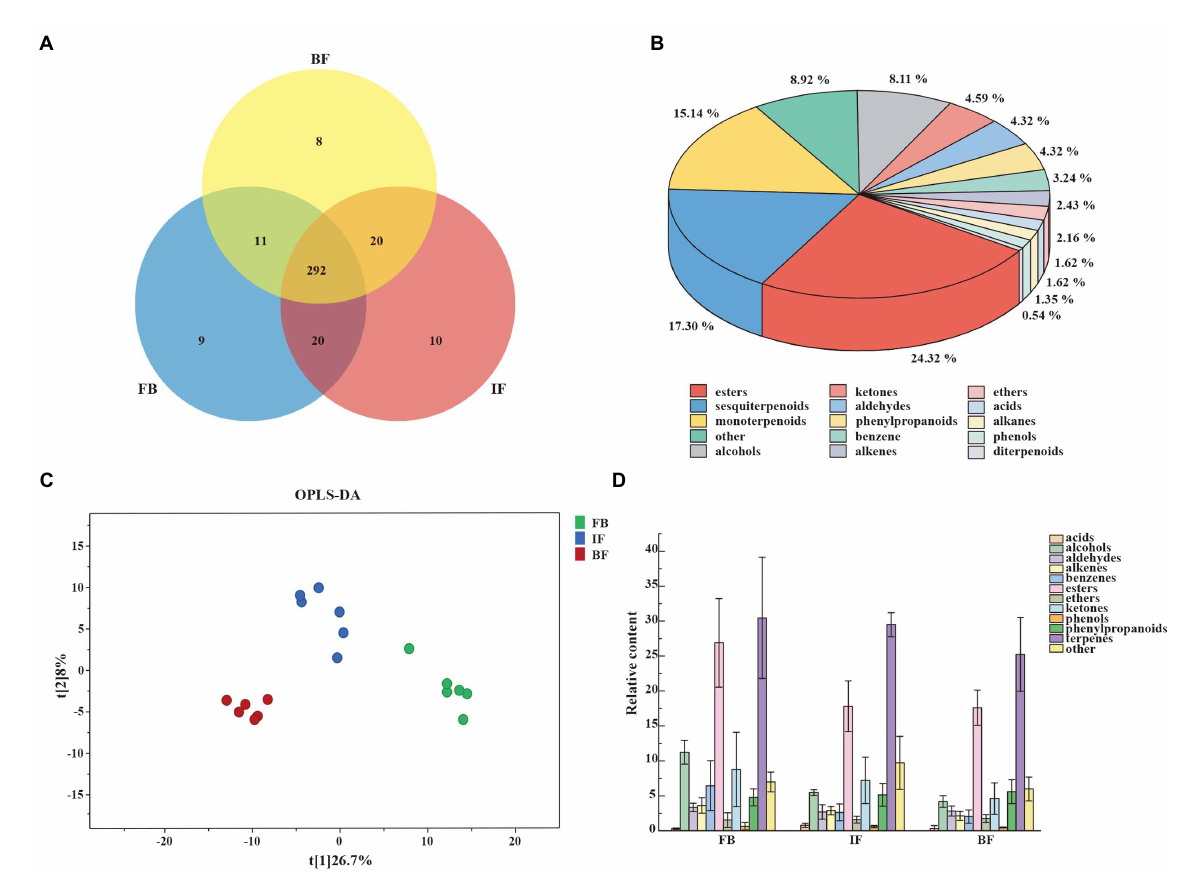
FIGURE 1 Characterization of volatile compounds identified in Chrysanthemum indicum var. aromaticum (CIA) flowers. (A) Venn diagram of volatile compounds in CIA flowers. (B) General classification of volatile substances. (C) OPLS-DA score plots showing clusters of CIA flower samples ( n = 3). (D) Trends in the release of volatile metabolites during flower opening at the flower bud (FB), initial flower (IF), and blooming flower (BF)